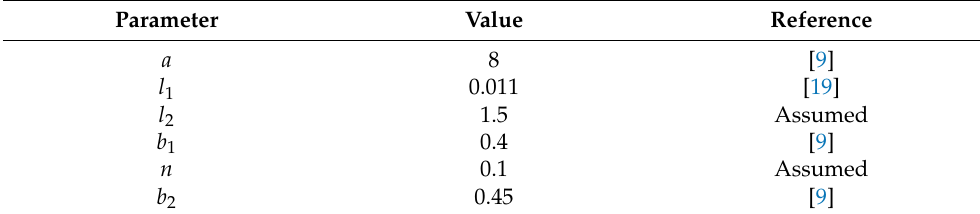
Table 1. The parameter values and sources. Parameter Value Reference a 8 [9] l 1 0.011 [19] 1.5 Assumed 0.4 [9] 0.1 Assumed b 2 0.45